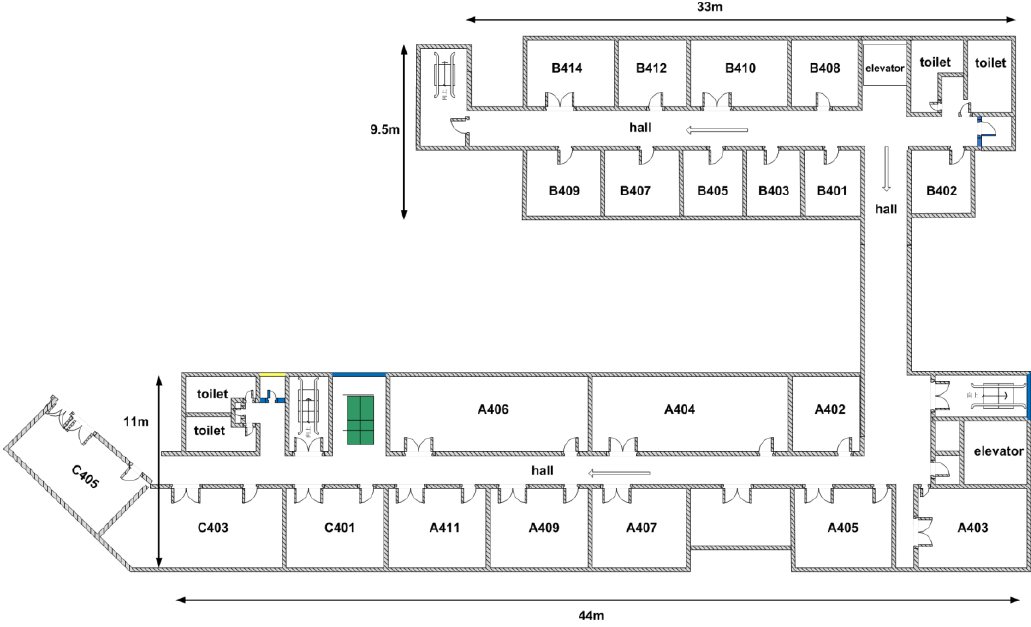
Figure 6. Layout of the experimental environment.